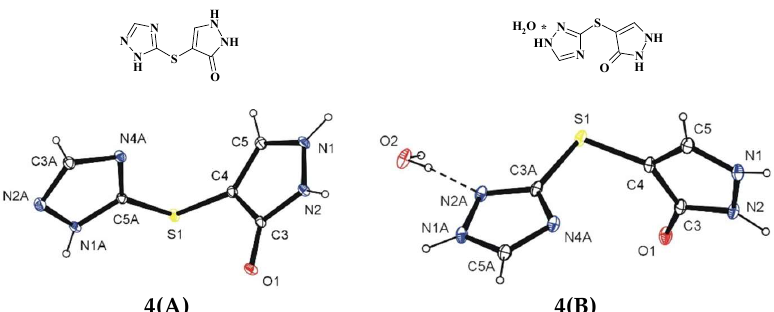
Figure 1. The molecular structures of compound 4 in the crystals 4(A) and 4(B) .